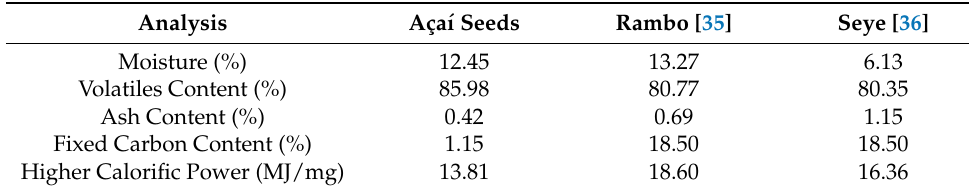
Table 1. Physical characterization of aça í